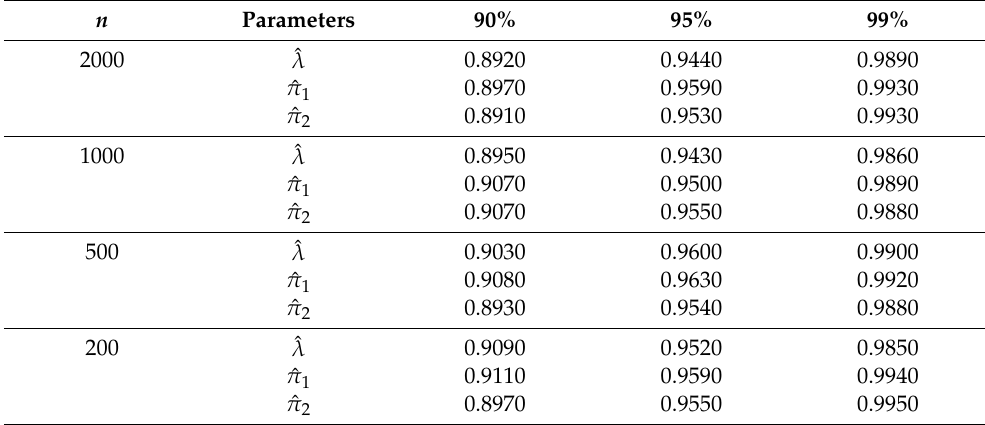
Table 6. Comparison of coverage probabilities of the simulated data. True values λ = 2, π 1 = 0.2, π 2 = 0.4, and k =